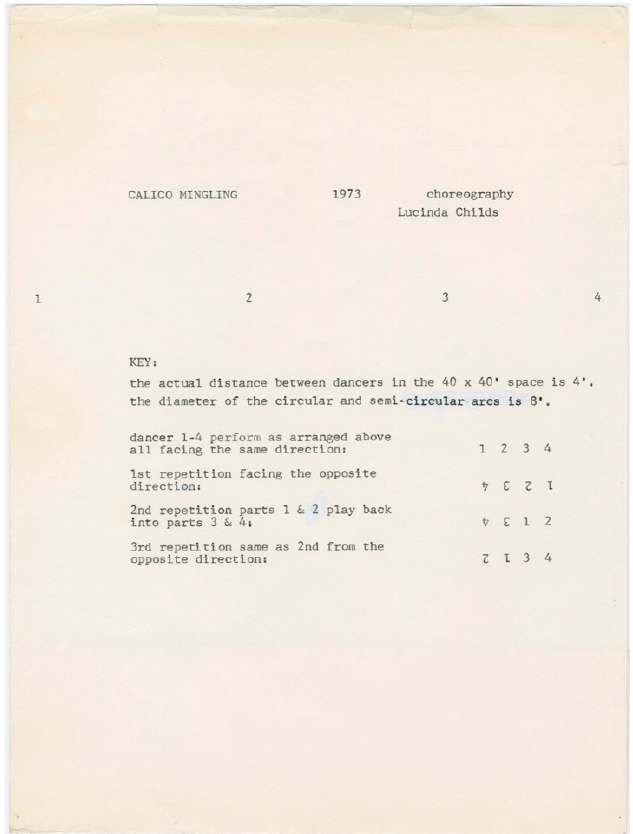
Figure 2. Lucinda Childs, Compositional chart for Calico Mingling (1973), typescript, 14” × 8.5”, Fonds Lucinda Childs—Médiathèque du Centre national de la danse.